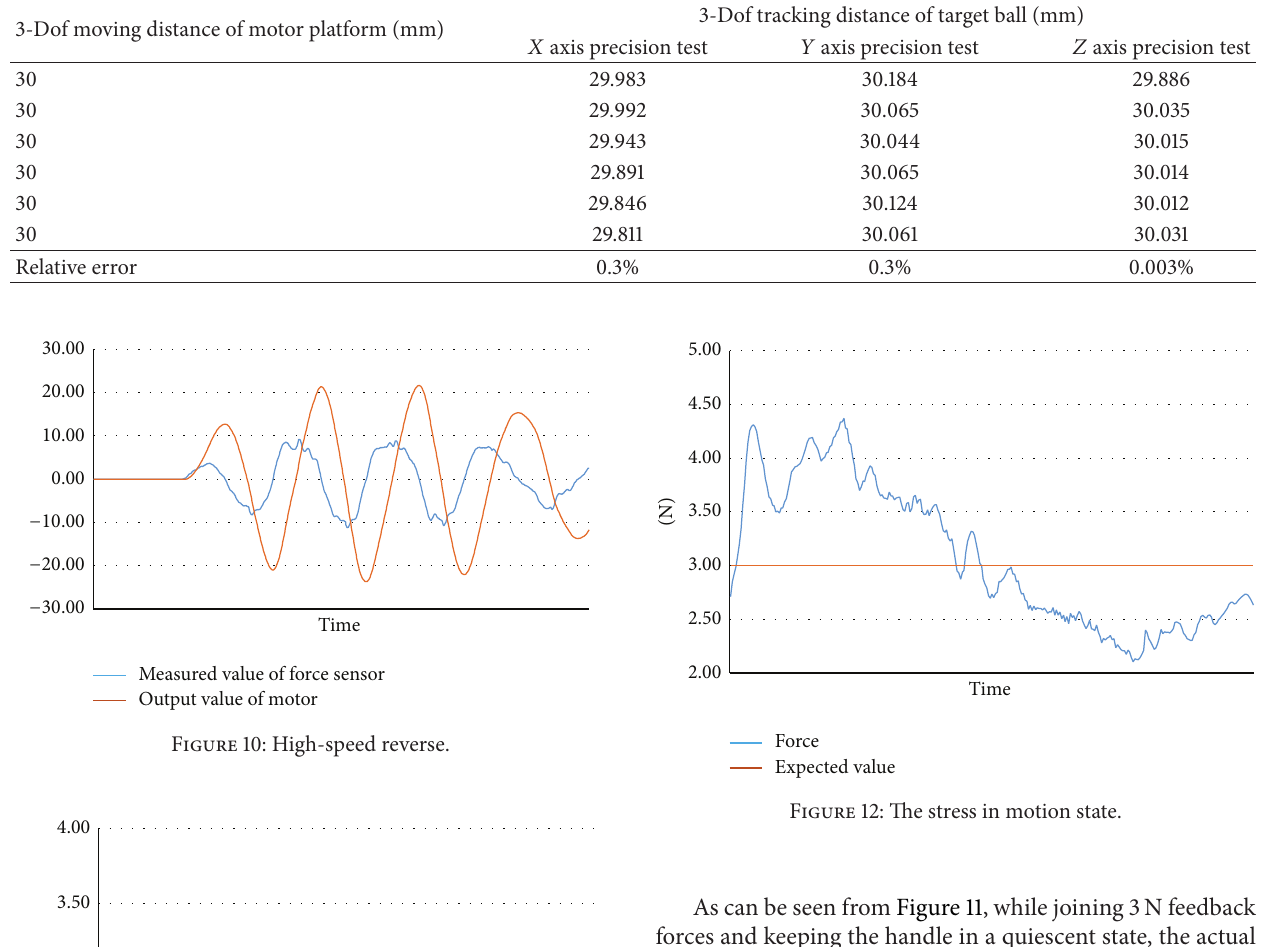
Table 2: The position precision of hand controller.